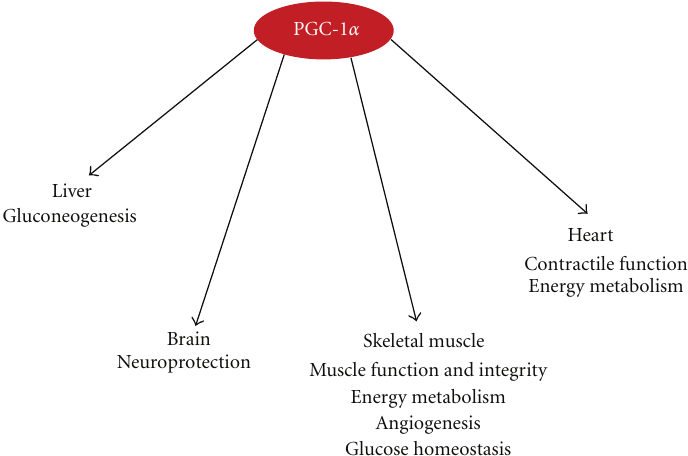
Figure 2: Tissue-specific function of PGC-1 α relevant to age-related pathologies. Di ff erent functions of PGC-1 α in heart, liver, brain, skeletal muscle and heart are depicted. These functions might be beneficial in age-associated pathologies as described in detail in the